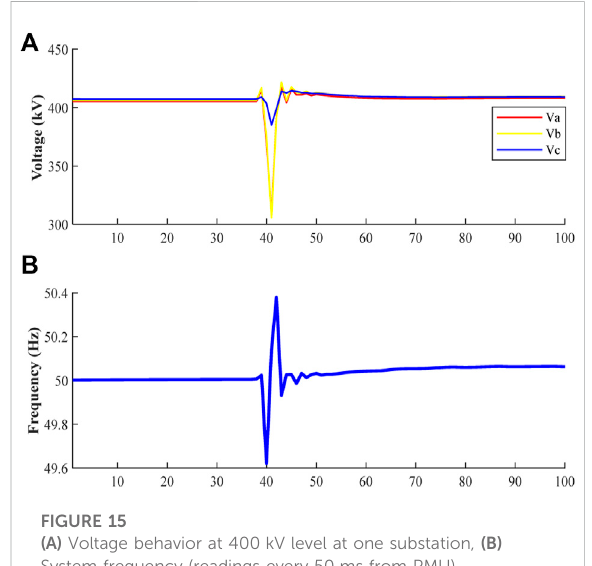
FIGURE 15 (A) Voltage behavior at 400 kV level at one substation, (B) System frequency (readings every 50 ms from